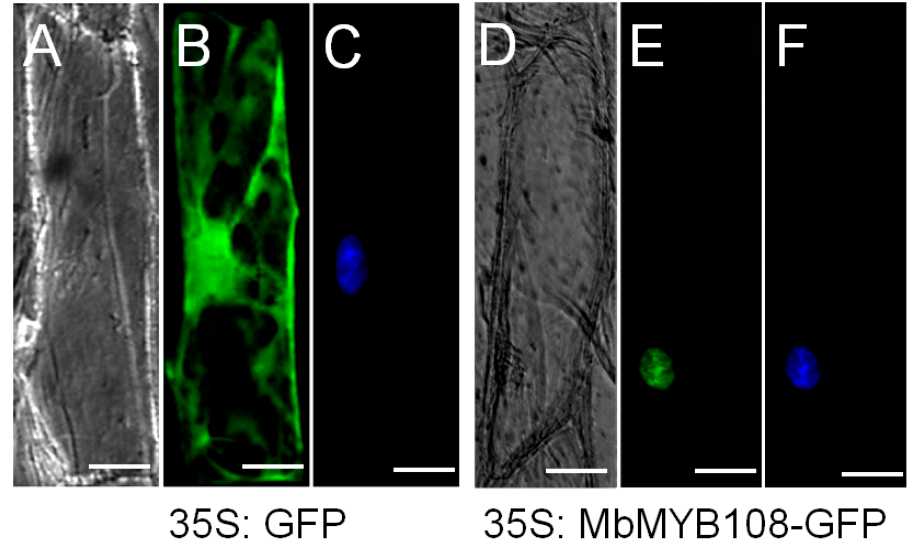
Figure 3. Subcellular localization of MbMYB108 protein. Transient expressions of green fluorescent protein (GFP) and MbMYB108 -GFP fusion protein in onion epidermal cells was observed by fluo- rescence microscopy: ( A , D ) were taken under bright light, ( B , E ) were taken under dark field, and ( C , F ) are the results of DAPI staining for 24 h. Scale bar corresponds to 5 μ m.